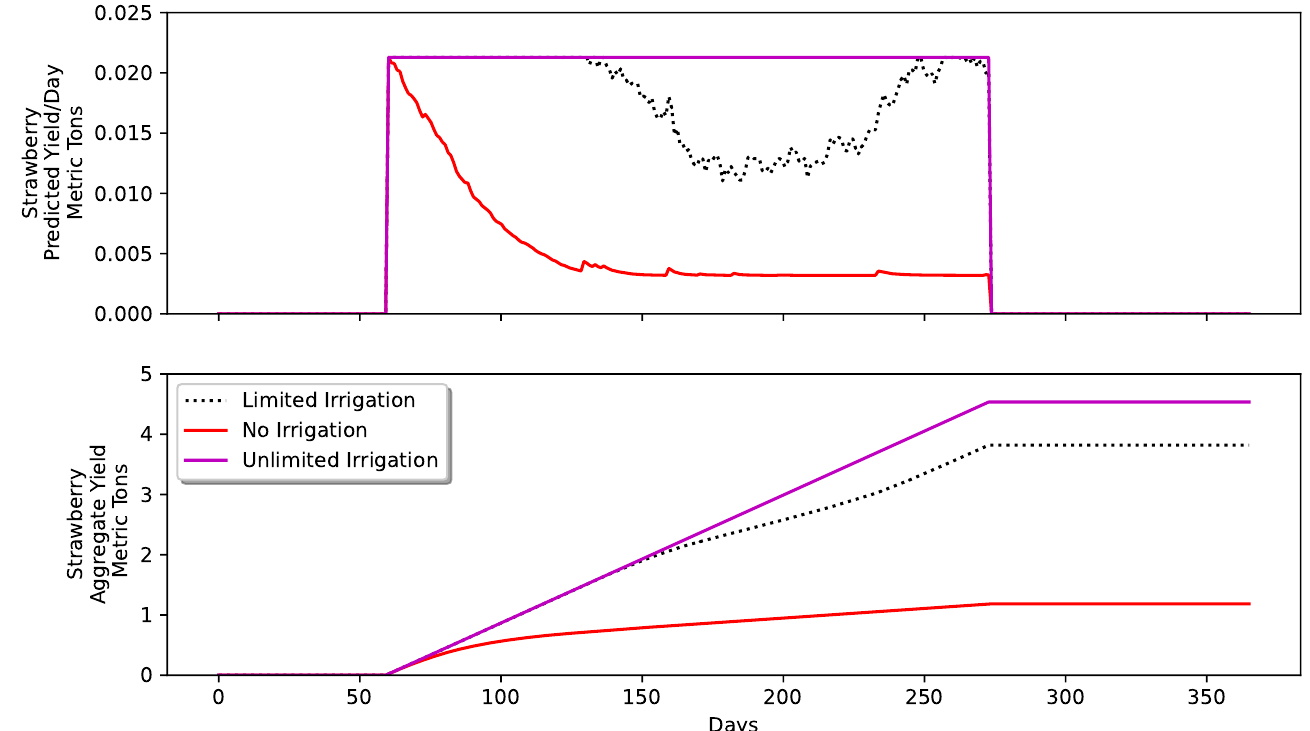
Figure 6. Strawberry yield rates for a single growing season with varying irrigation settings. As expected, crop yield diminishes when water needs are not met. Despite variability in environmental parameters, the constant yield rate in the unlimited irrigation scenario indicates that in our model, supplemental water is sufficient to ensure maximal yields. In our model, the yield rate ( top plot) varies continuously in time and represents the amount of of biomass added to the crop that could be harvested on a a future date. The aggregate yield ( bottom plot) is simply the cumulative sum of the yield rate and represents the potential size of a future harvest.